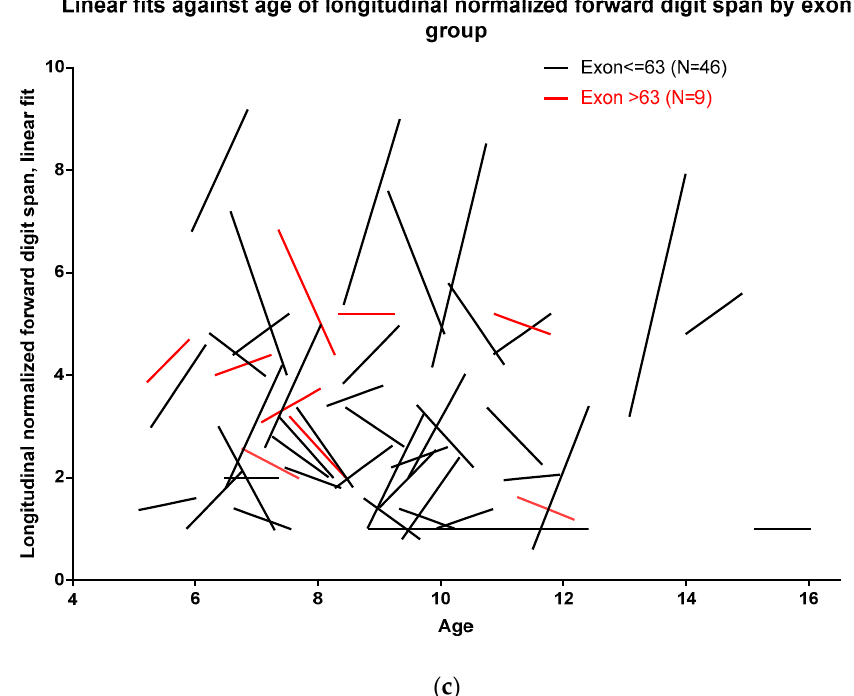
Figure 5. ( a–c ) Developmental modeling of forward digit span based on nonsense DMD (nmDMD) Figure 5. ( a – c ) Developmental modeling of forward digit span based on nonsense DMD (nmDMD) mutation location. mutation